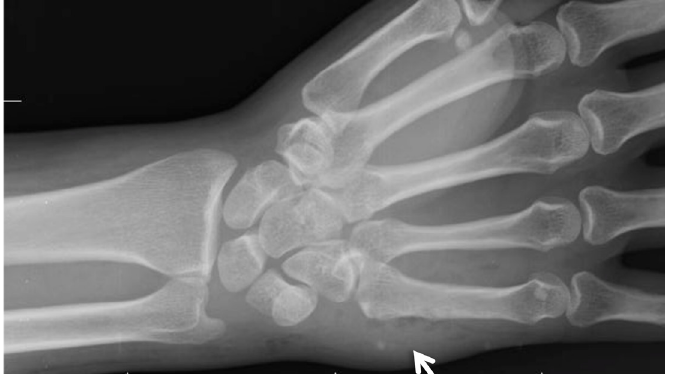
Figure 4. Fasciotomy of forearm shows diffuse fat necrosis of Patient